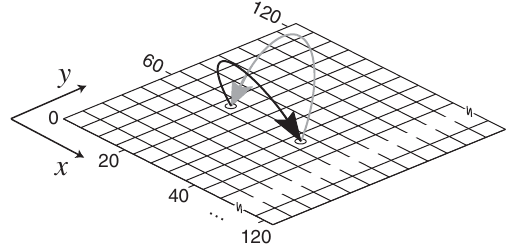
FIG. 1. Long-range two-point connections on a 120 (cid:1) 120 grid representing a 25 - cm (cid:1) 25 - cm square of flattened cortical tissue. The diagram shows direct axonal connections from co- ordinate ð x 1 ; y 1 Þ ¼ ð 20 ; 60 Þ to ð x 2 ; y 2 Þ ¼ ð 40 ; 60 Þ (black arrow), and back (gray arrow). Communication between connected points occurs after a time delay (cid:1) t ¼ (cid:1) r=v , where v is the axonal conduction speed and (cid:1) r is the physical separation ð L=N x Þj x 1 (cid:2) x 2 j , with L ¼ 25 cm and N x ¼ 120 . We apply periodic (toroidal)